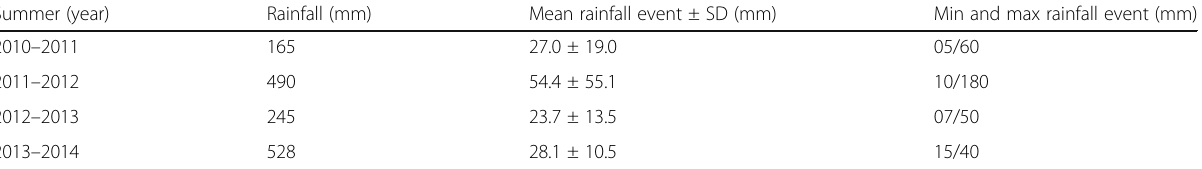
Table 1 Annual rainfall recorded in the study area during the wet season Summer